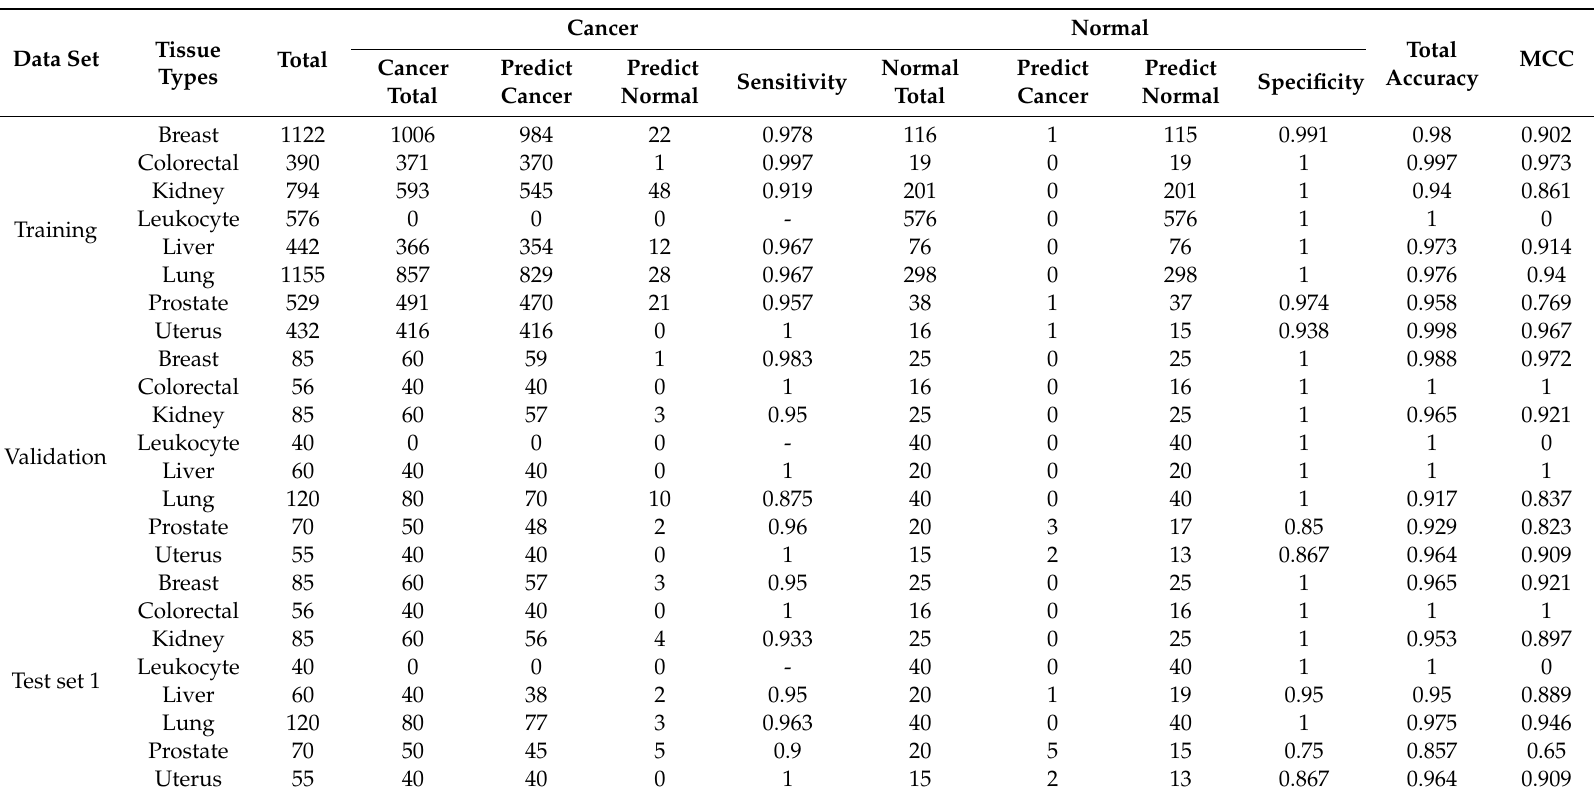
Table 5. The prediction results of three data sets for 13 promoter